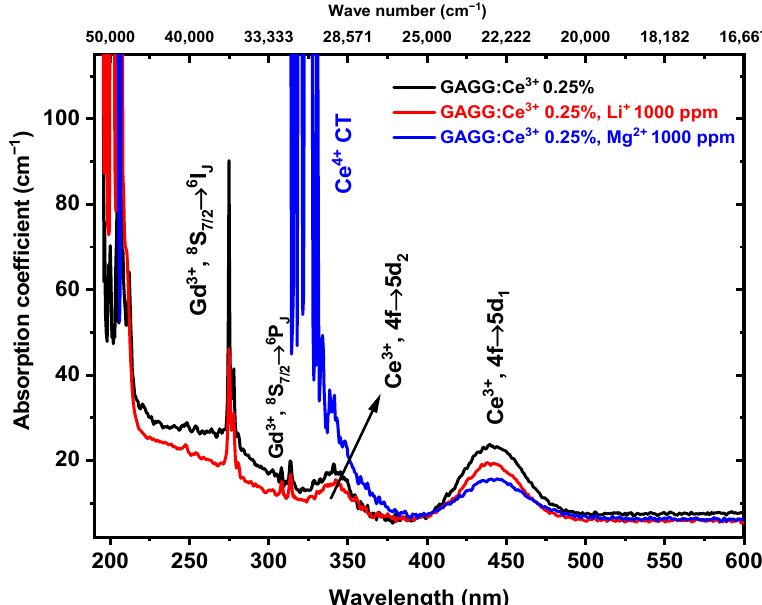
Figure 4. Absorption spectra of Li + :Ce 3+ and Mg 2+ :Ce 3+ doped GAGG crystals, 300 K.